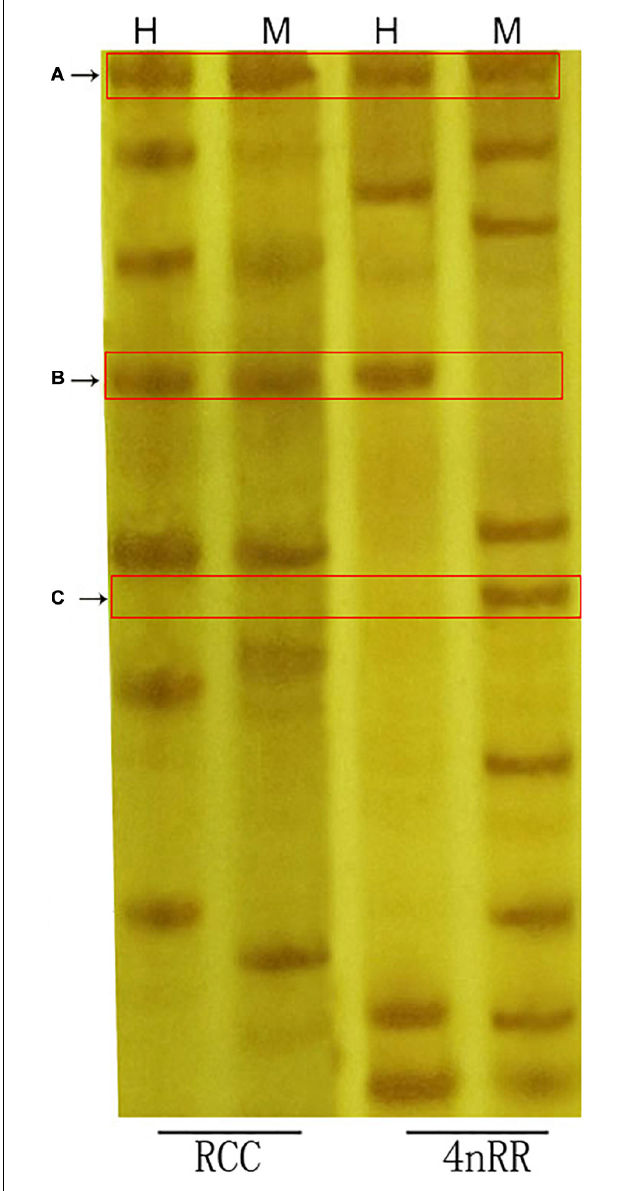
FIGURE 5 | Examples of MSAP analysis. Parts (A–C) represent bands corresponding to the methylation types with these labels in Table 3 . H, sample digested with Eco RI /Hpa II; M, sample digested with Eco RI/ Msp